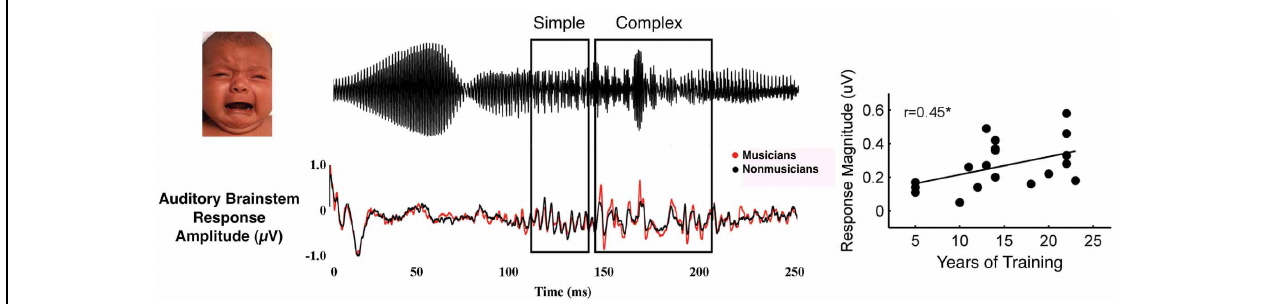
FIGURE 3 | Musician subjects demonstrate enhanced subcortical encoding (bottom waveform) to the complex portion of an emotional communication sound—a baby’s cry (top waveform, see boxes dividing